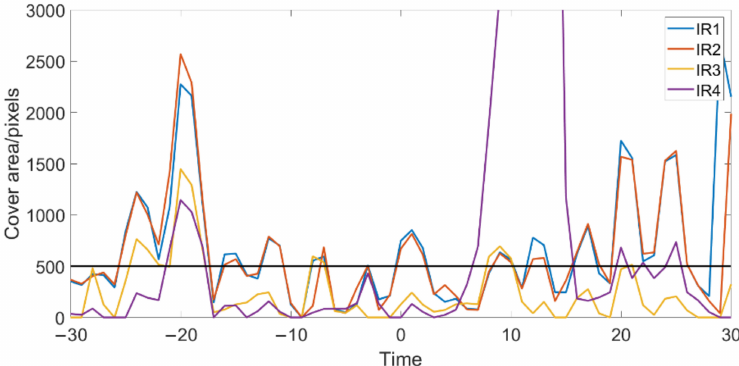
Figure 11. The cover area of the anomalies before and after the Sichuan